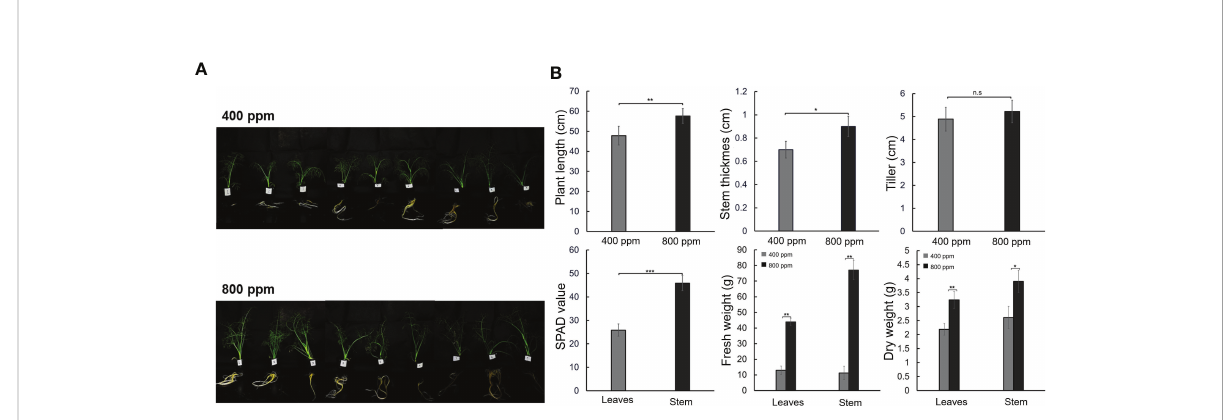
FIGURE 1 Growth characteristics in fennel under different CO 2 treatments (400 and 800 ppm). (A) Phenotypes of fennel four weeks. (B) Growth differences is fennel over fi ve weeks between CO 2 treatments. The values represent the mean ± standard deviation (n = 9). Statistical signi fi cance is based on two-tailed Student ’ s t -test (*p < 0.05, **p < 0.01, ***p < 0.001, n.s, non-signi fi